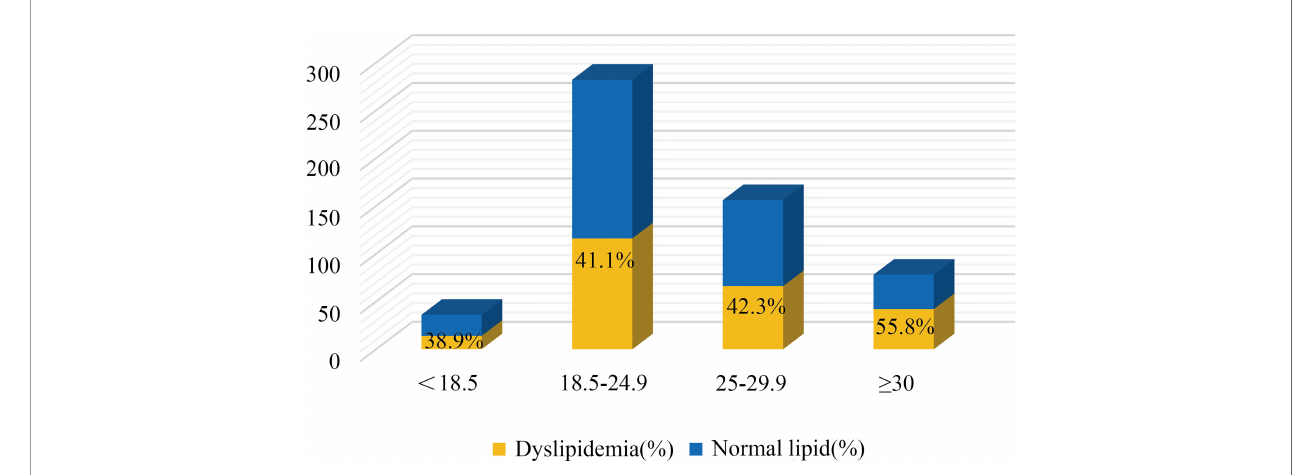
FIGURE 1 | The distribution of patients with dyslipidemia in different BMI subgroups. P = 0.220.